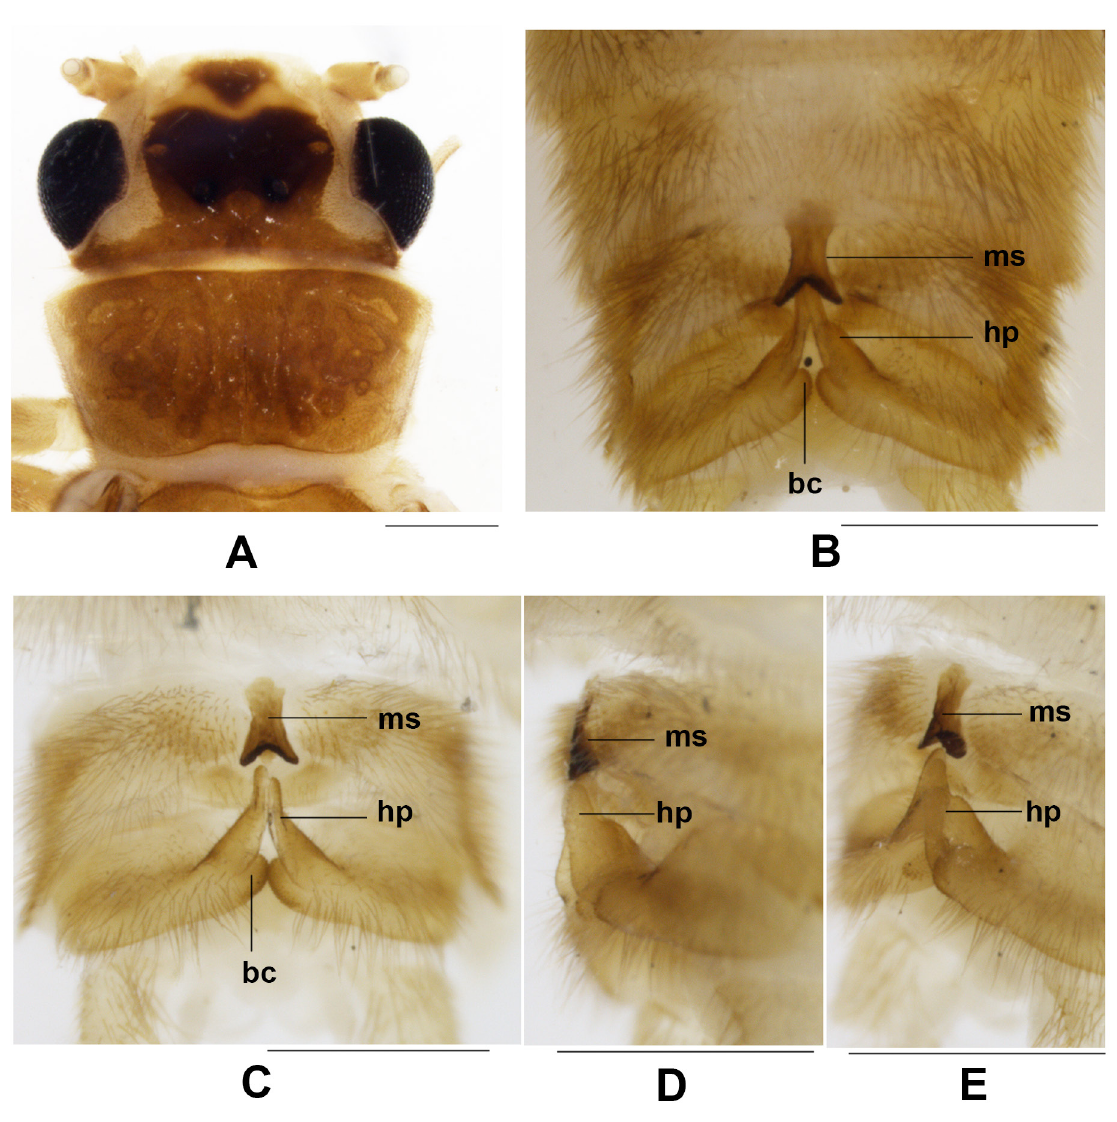
Fig. 9. Chinoperla nigrifrons (Banks, 1939), ♂ from Mount Yinggeling (HIST). A . Head and pronotum, dorsal view. B . Terminalia, dorsal view. C . Cleared terminalia, dorsal view. D . Cleared terminalia, lateral view. E . Cleared terminalia, oblique lateral view. Abbreviations: see Material and methods. Scale bars = 0.5